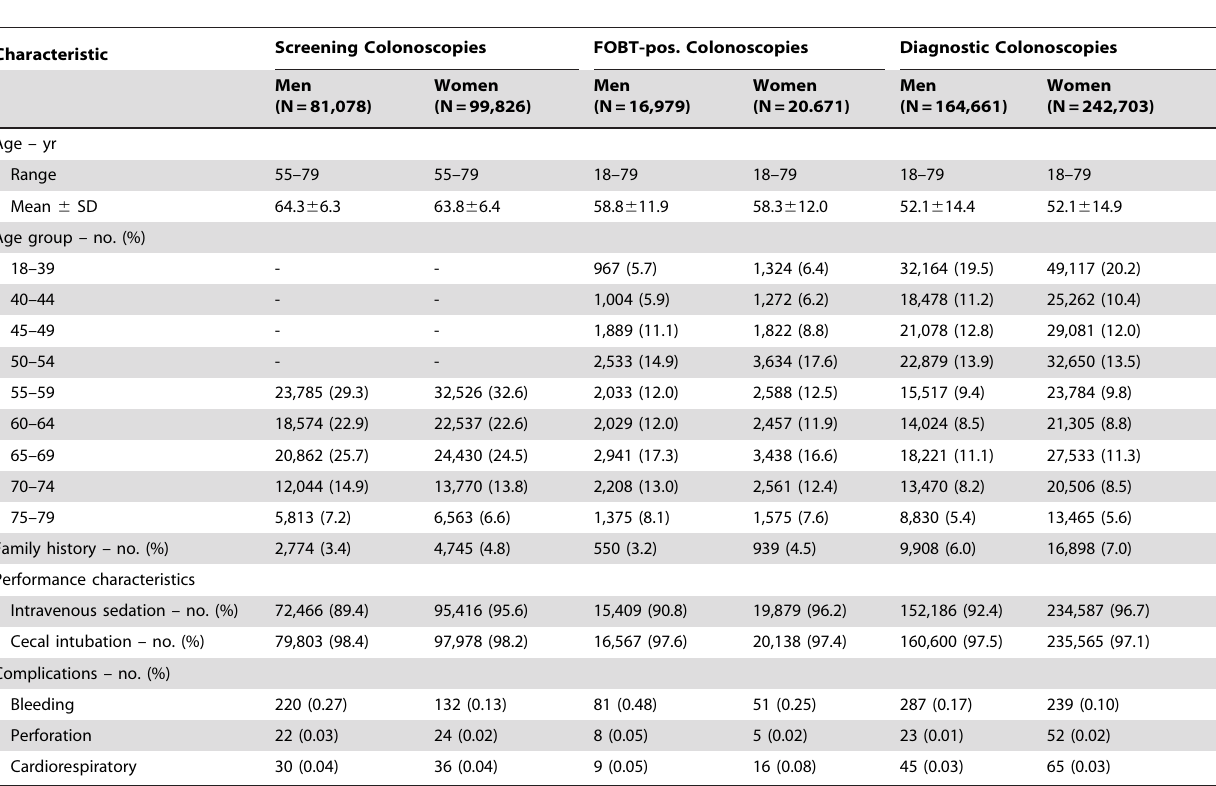
Table 1. Demographic characteristics for the 625,918 participants aged 18 to 79 years in diagnostic and screening colonoscopy.